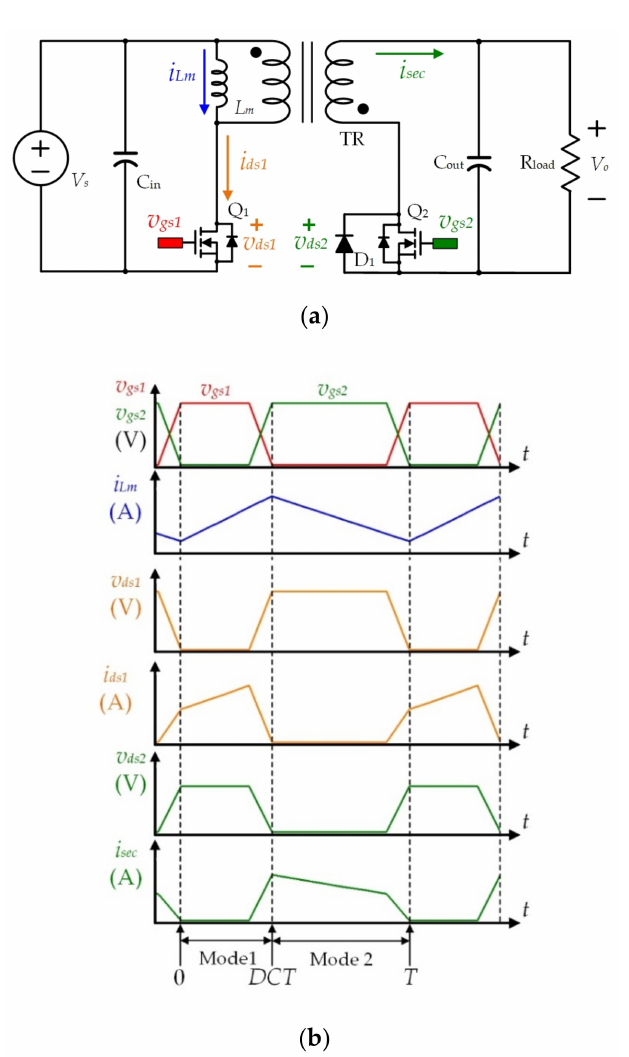
Figure 2. ( a ) Schematic diagram of the DSBFC without the full-bridge rectifier; ( b ) the corresponding key